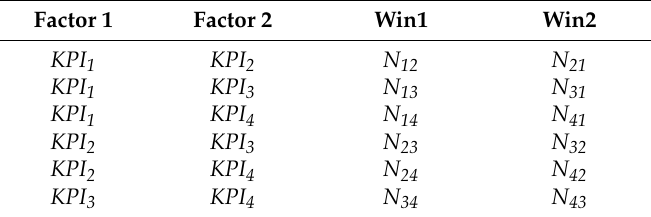
Table 5. Data aggregation example for the Bradley-Terry calculation in a win-to-loss